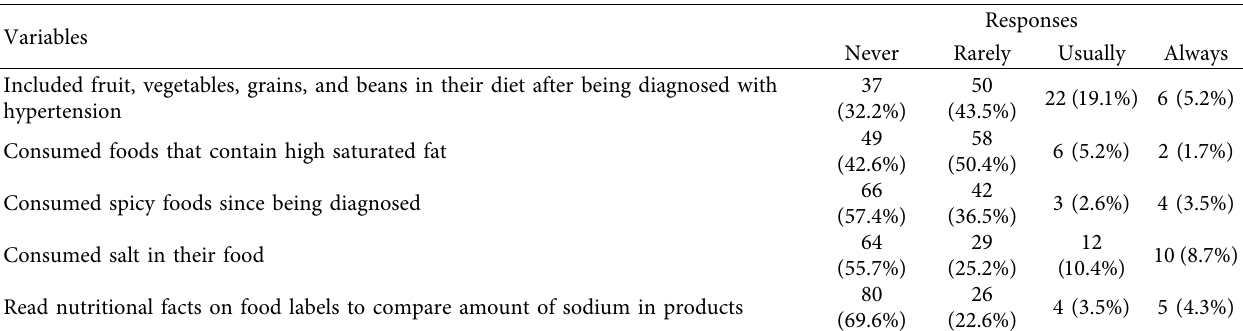
Table 3: Adherence to dietary modifications among hypertensive patients in a follow-up clinic of Asella Referral and Teaching Hospital, Asella Town, Arsi Zone, Oromia Regional State, Ethiopia, 2020 ( n � 115). Variables Included fruit, vegetables, grains, and beans in their diet after being diagnosed with Consumed foods that contain high saturated fat